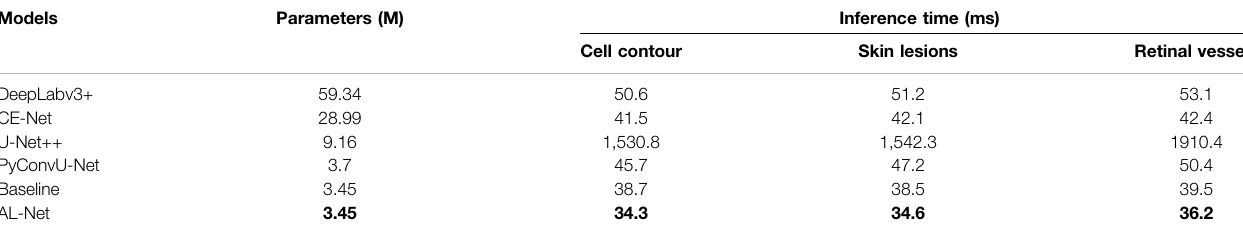
TABLE 5 | The evaluation of parameters and inference time of six models. Models